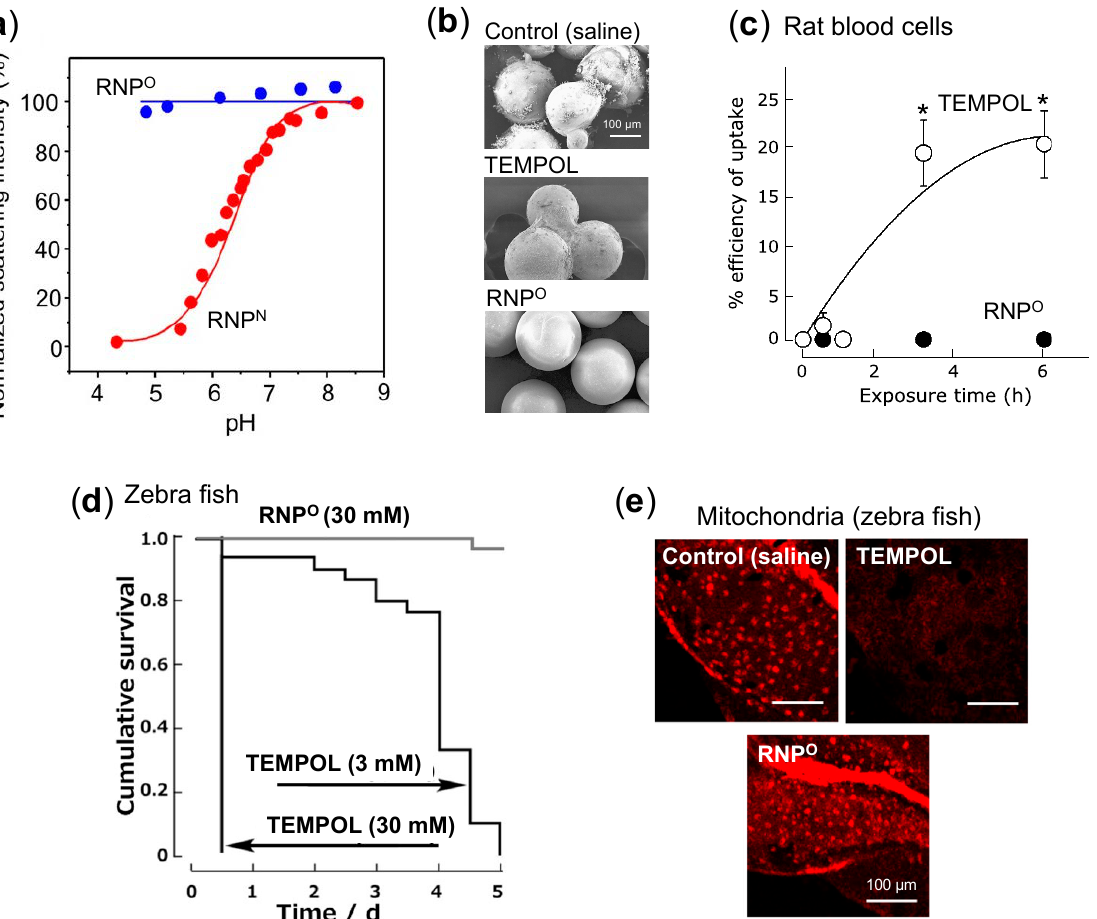
Figure 3. Characterization and non-toxicity of RNPs. ( a ) Laser light scattering intensity of RNP O and RNP N as a function of pH, assessed by dynamic light scattering [77]. ( b ) SEM images of glass beads spiked in rat whole blood with saline, TEMPOL, and RNP O (5 mM) for 30 min [85]. ( c ) The cellular uptake of TEMPOL and RNP O by rat whole blood cells evaluated by ESR [85]. ( d ) Cumulative survival of zebrafish embryo maintained in RNP O (30 mM) and TEMPOL (3 and 30 mM) [88]. ( e ) Microscopic images of the mitochondrial damage in zebrafish larva after 12 h of treatment, assessed by mitotracker and analyzed using a fluorescent confocal microscope system, scale bar 100 µ m [88]. * p < 0.05 was considered significant. This figure is reproduced with permission from References [77,85,88]. Copyright 2011, Elsevier; Copyright 2014, JCBN; Copyright 2016, American Chemical